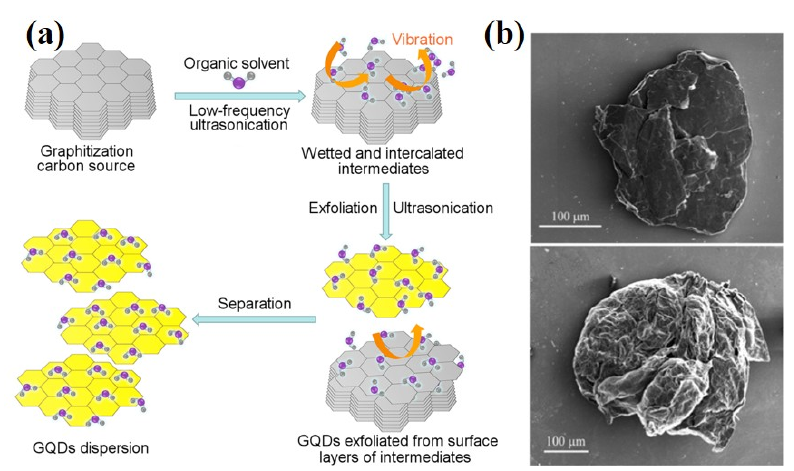
Figure 8. ( a ) Schematic illustration of the preparative process of GQDs by ultrasonic-assisted exfoliating graphitic carbon precursors (acetylene black, nano-graphite) in organic solvents. Reprinted with permission from Ref. [109]. Copyright 2016, Elsevier. ( b ) SEM images comparing graphite before ( top ) and after ( bottom ) the microwave expansion. Reprinted with permission from Ref. [110]. Copyright 2018, Elsevier.